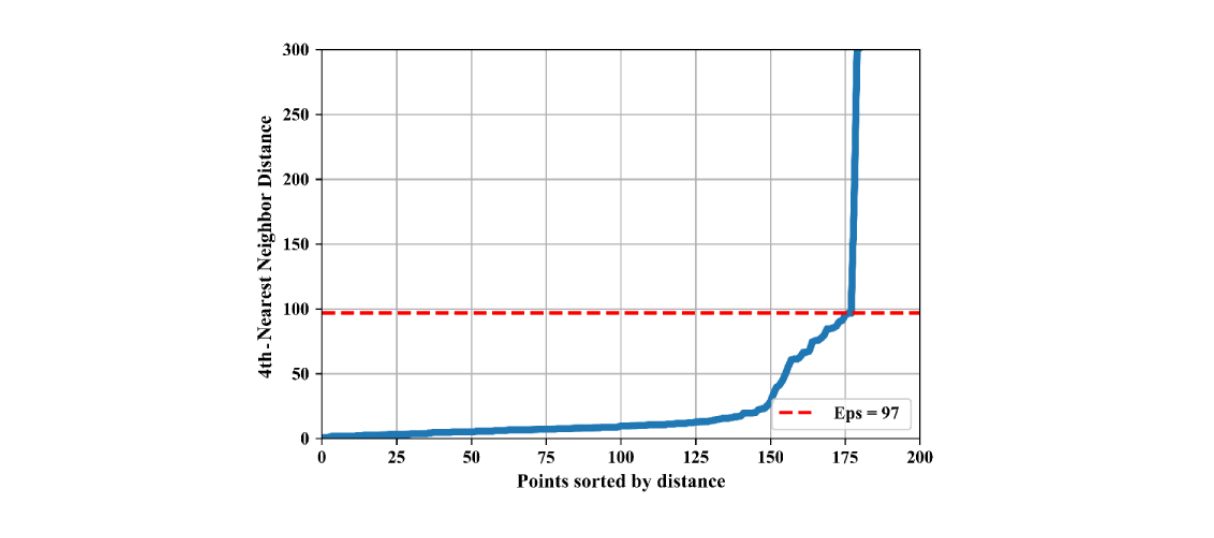
Figure 3. Participant 1's fourth-nearest neighbor distance. Eps : cluster radius.